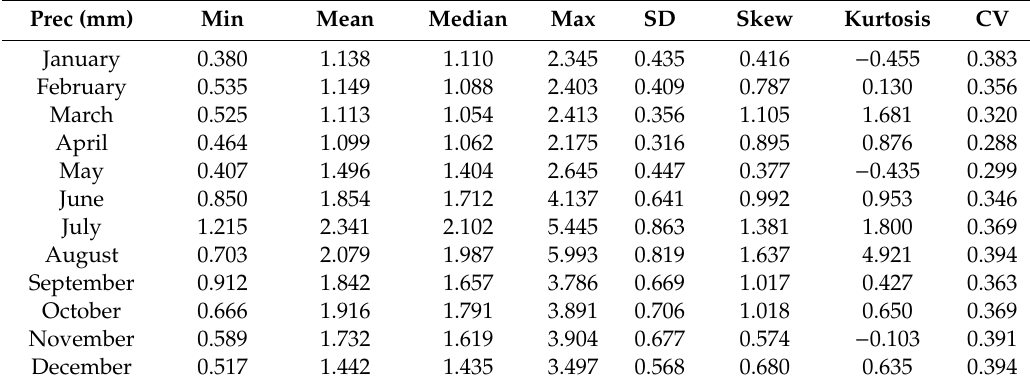
Table 3. The average statistical properties of calculated monthly Erosivity Density ( ED ) (MJ / ha / h). SD is an abbreviation for standard deviation and CV for coe ffi cient of variation (the ratio of the standard deviation to the mean).